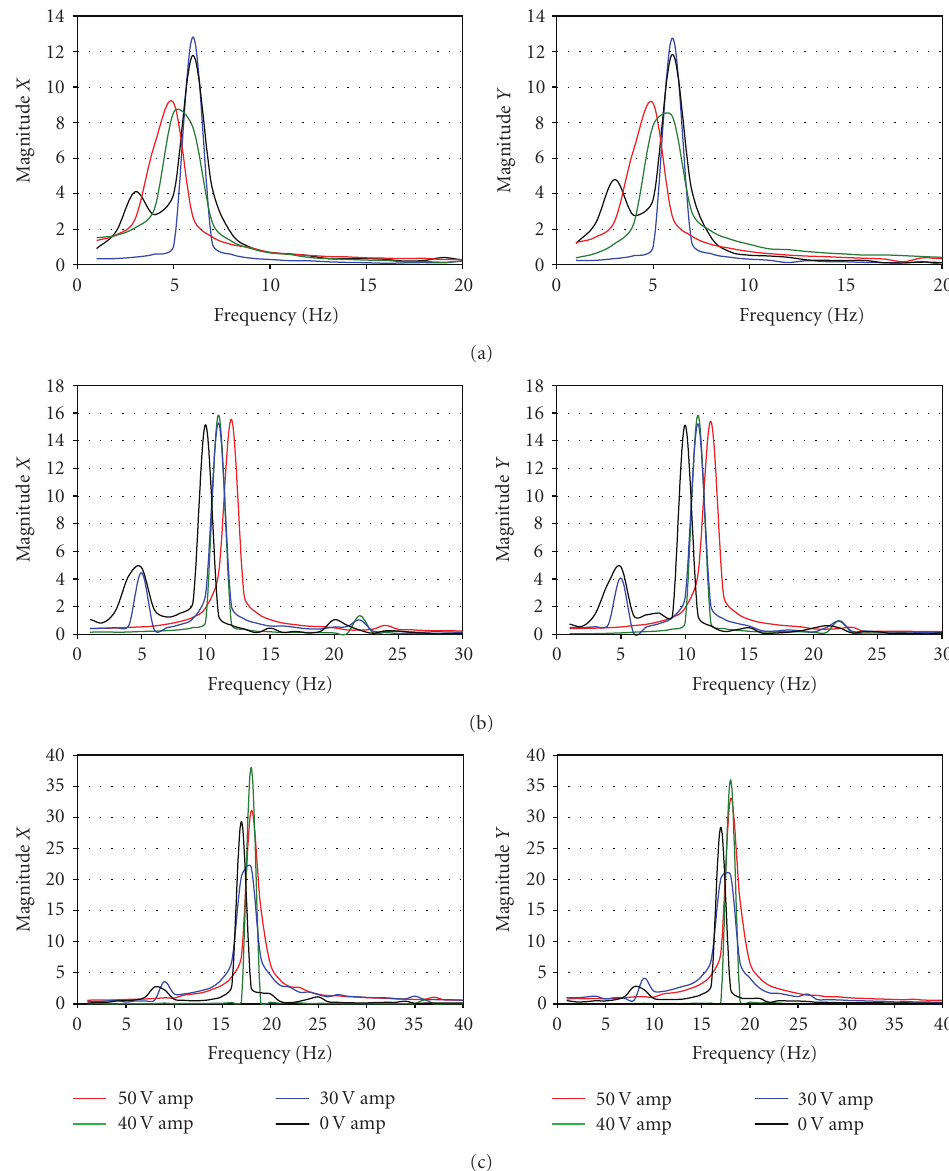
Figure 8: FFT responses [ μ m] of rotor orbits ω = 1500Hz, zero load: (a) Ω = 320rpm, (b) Ω = 630rpm, and (c) Ω = 1020rpm.